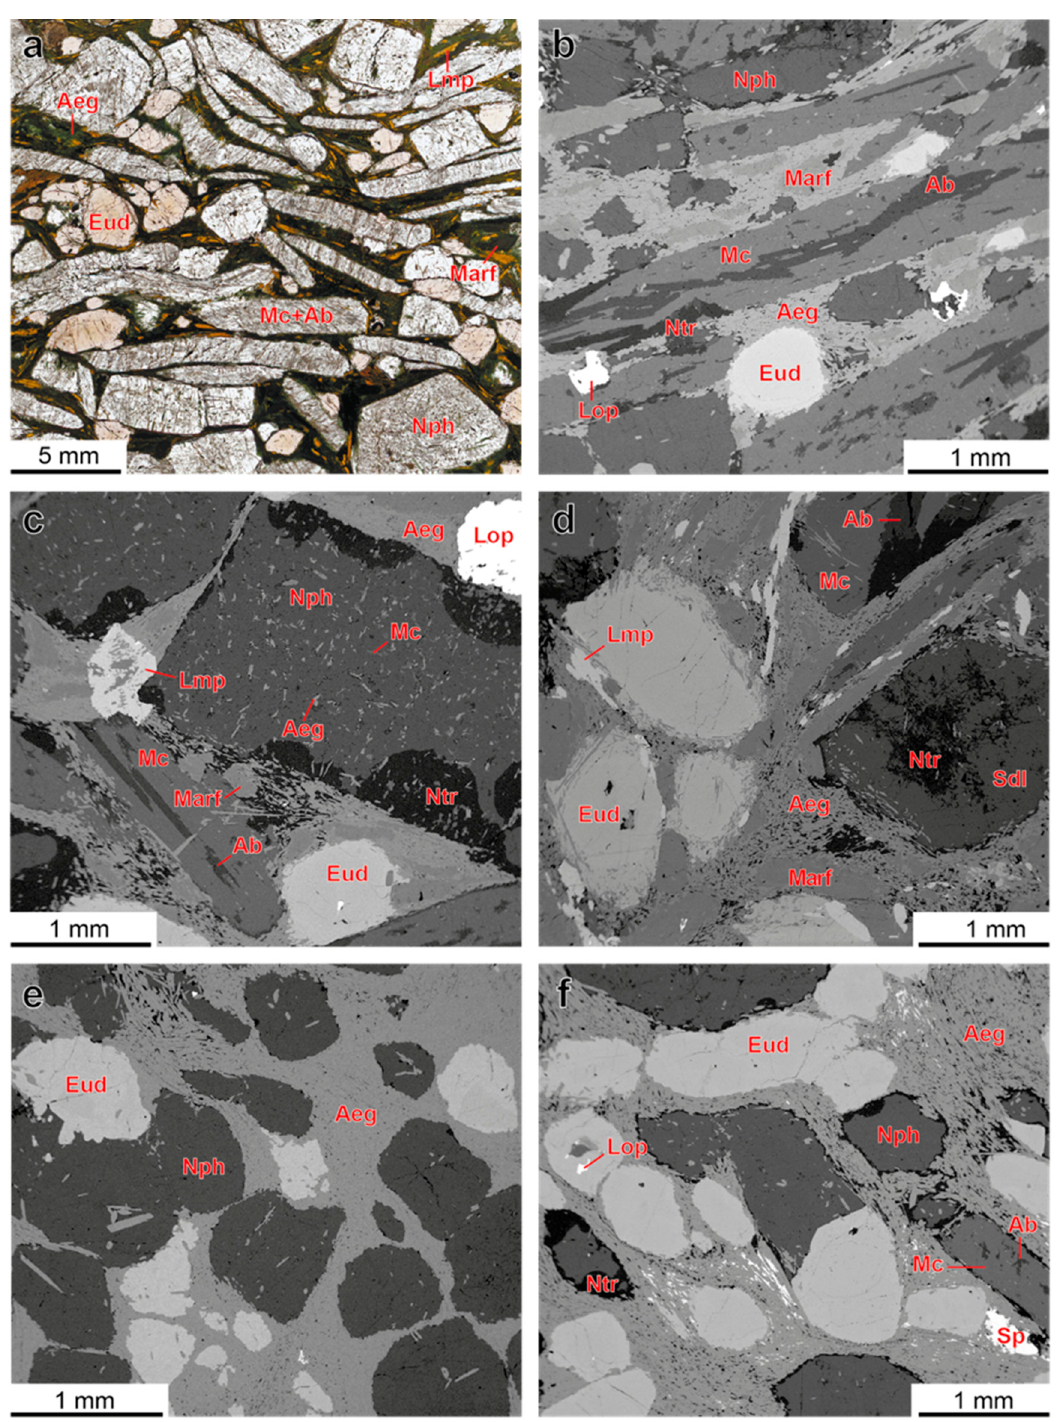
Figure 3. Meso-melanocratic rocks of the Alluaiv site: ( а )—EGM-rich trachytoid malignite (lujavrite) 117/76 (photo of polished thin section in transmitted light); ( b – d )—BSE images of EGM-rich malignites (lujavrites) 117/121 ( b ), 154/85 ( c ) and 29/37 ( d ); ( e )—BSE-image of EGM-rich ijolite 222/177; ( f )—BSE-image of shonkinite 32/42.4.